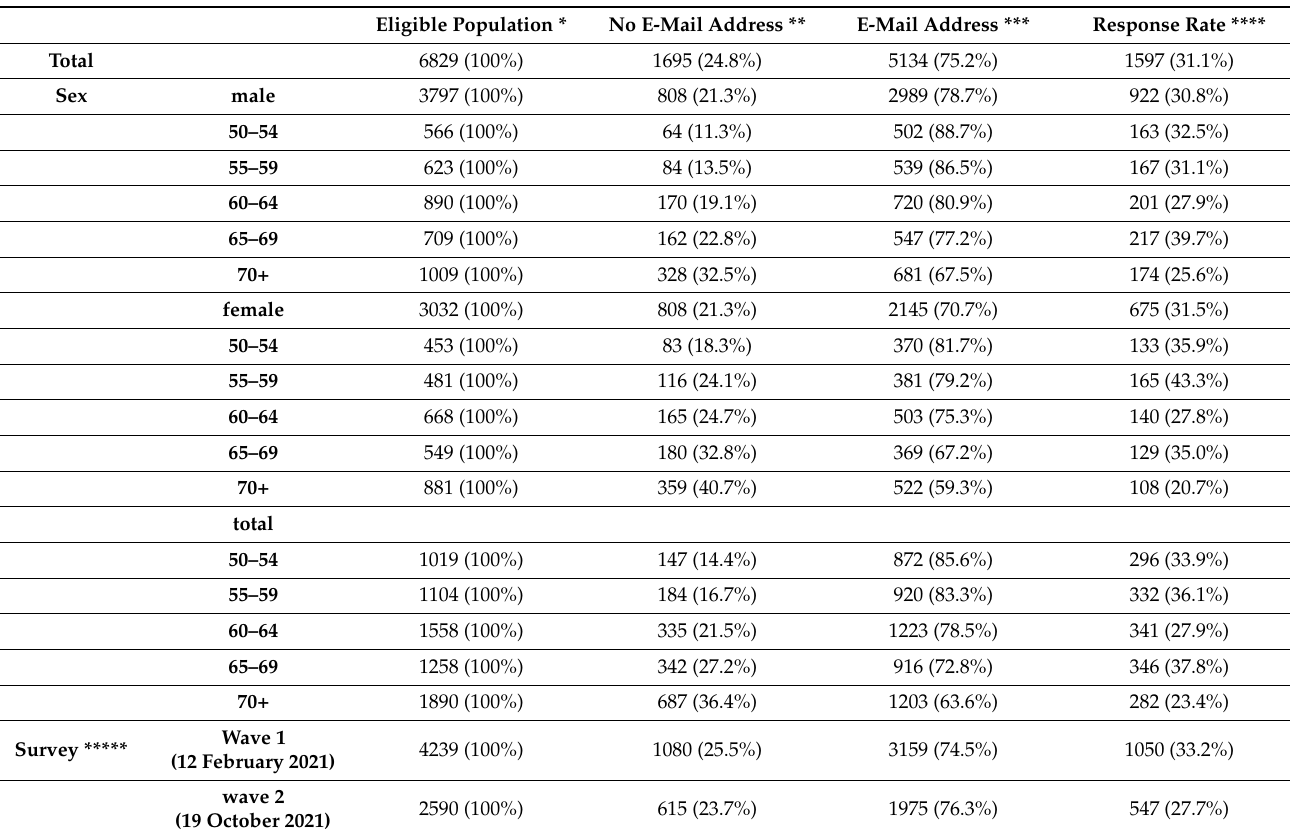
Table 1. Characteristics of the study population (in absolute numbers and percentages).